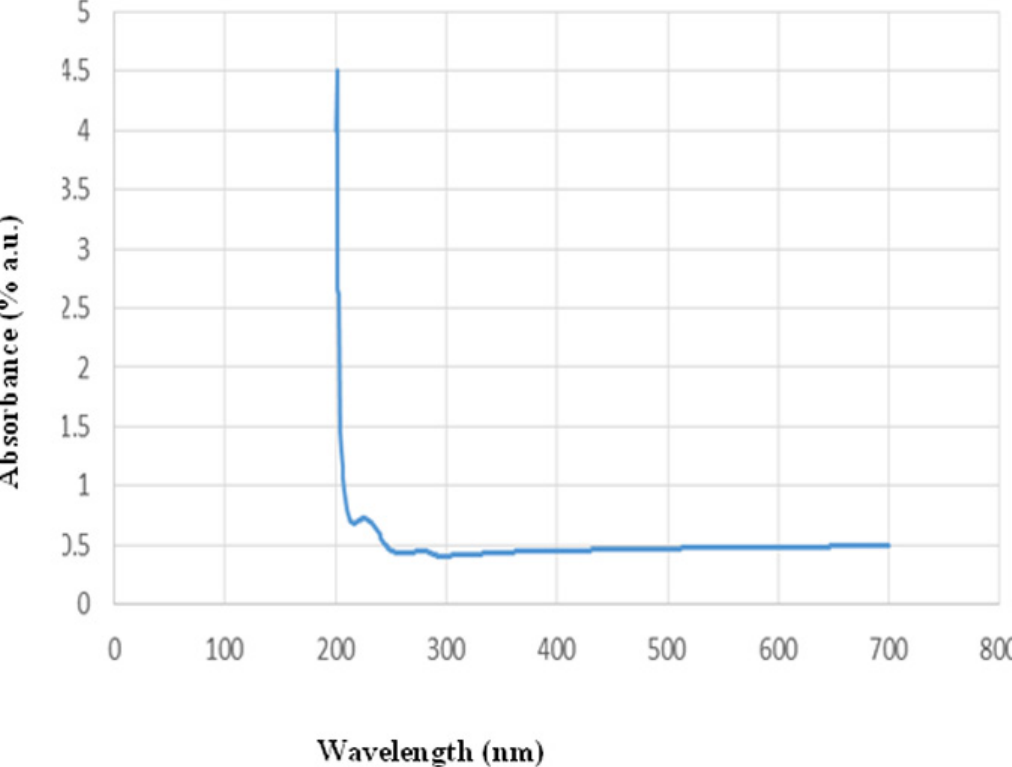
Figure 5: UV-Vis spectra of the mixture solution including synthesized CuO NPs at obtained optimum synthesis conditions.